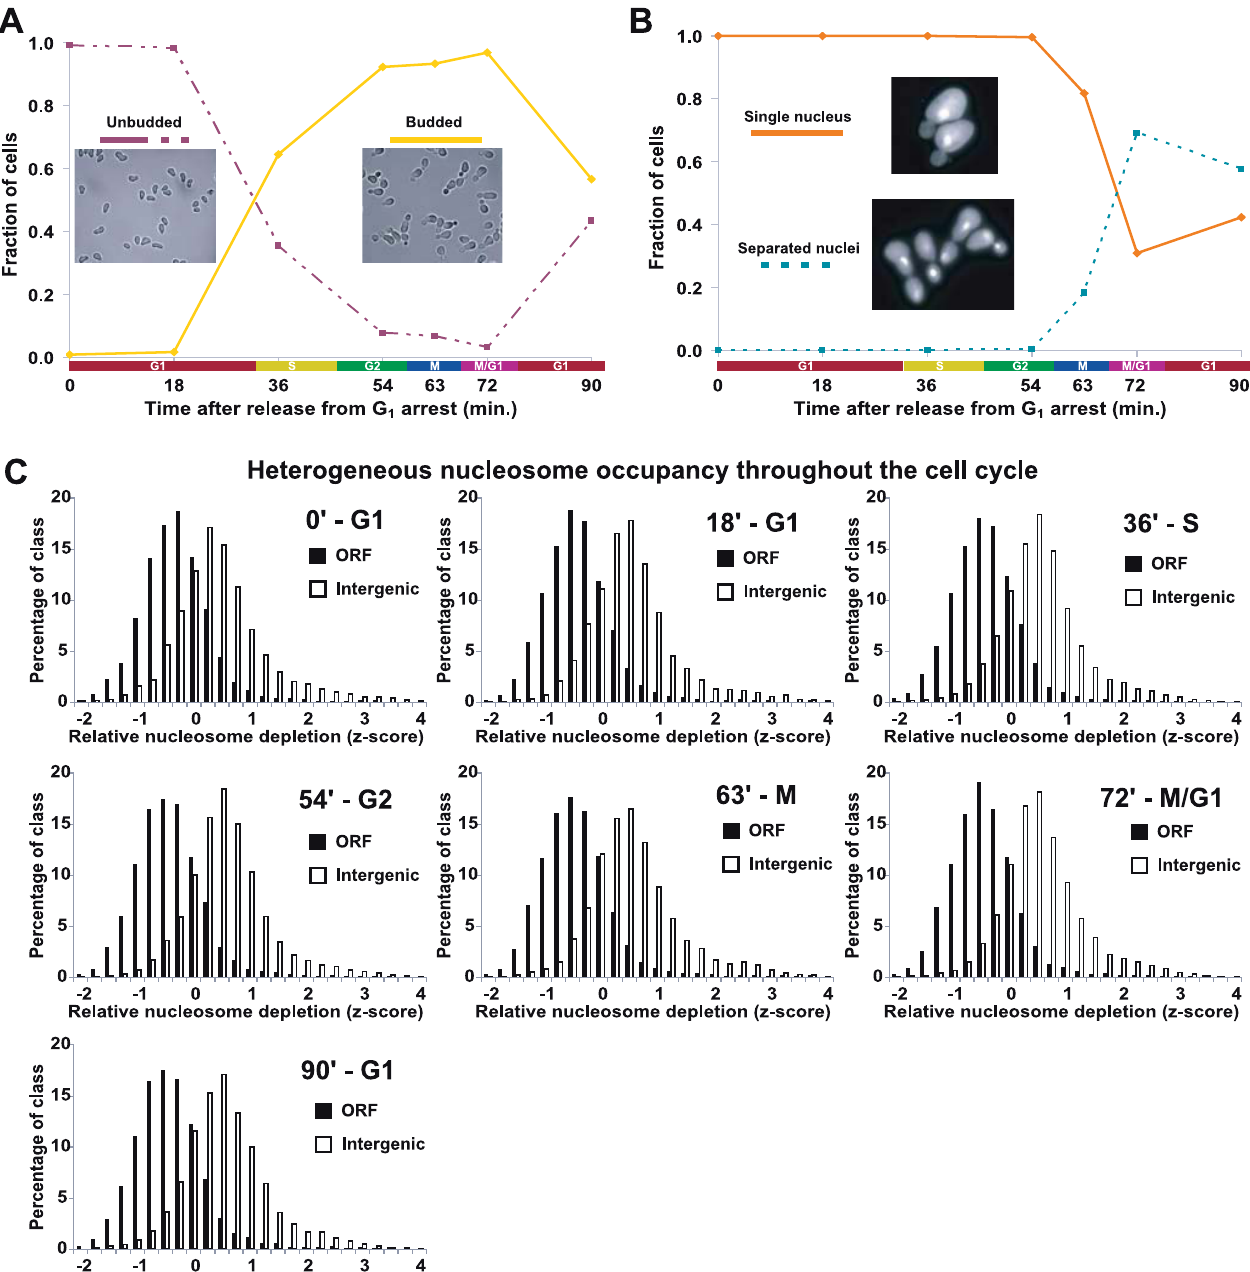
Figure 4. The Global Pattern of Nucleosome Occupancy Is Maintained throughout the Cell Cycle (A) To validate synchrony of cell cycle arrest and release, cells were scored as unbudded (G 1 ) or budded (other phase) using brightfield images of every time point from each time course as described (Materials and Methods). Each image represents one of the plotted groups, as indicated. Although the data shown were derived from a single time course, all time courses exhibit similar synchrony and growth. For a representative time course, Northern blots were performed using probes to CLN2 and the HHT transcripts, which also confirmed cell cycle synchrony and progression (unpublished data). (B) Same as (A), except cells from each time point were stained with DAPI. Each yeast cell was scored as having a single nucleus (pre-mitotic) or separated nuclei (post-mitotic). Greater than 90% arrest in late G 1 at the time of release was achieved for all cultures. Note that although the cells from the first time point (time 0) were arrested in G 1 , they were in a physiological state distinct from natural G 1 as the result of induction of a -factor– responsive genes. (C) The distribution of z -scores for SGD-annotated ORFs and intergenic non-coding segments plotted for each cell cycle time point. Each histogram is represented by all biological replicates collected at that time point. The approximate cell cycle phase is given next to the time after release from G 1 arrest. For our analysis, normalized median log 2 ratios from each array were transformed into z -scores to control for differences in variance between arrays, followed by calculation of mean z -scores for all biological replicates (Materials and Methods). DOI: 10.1371/journal.pgen.0020158.g004